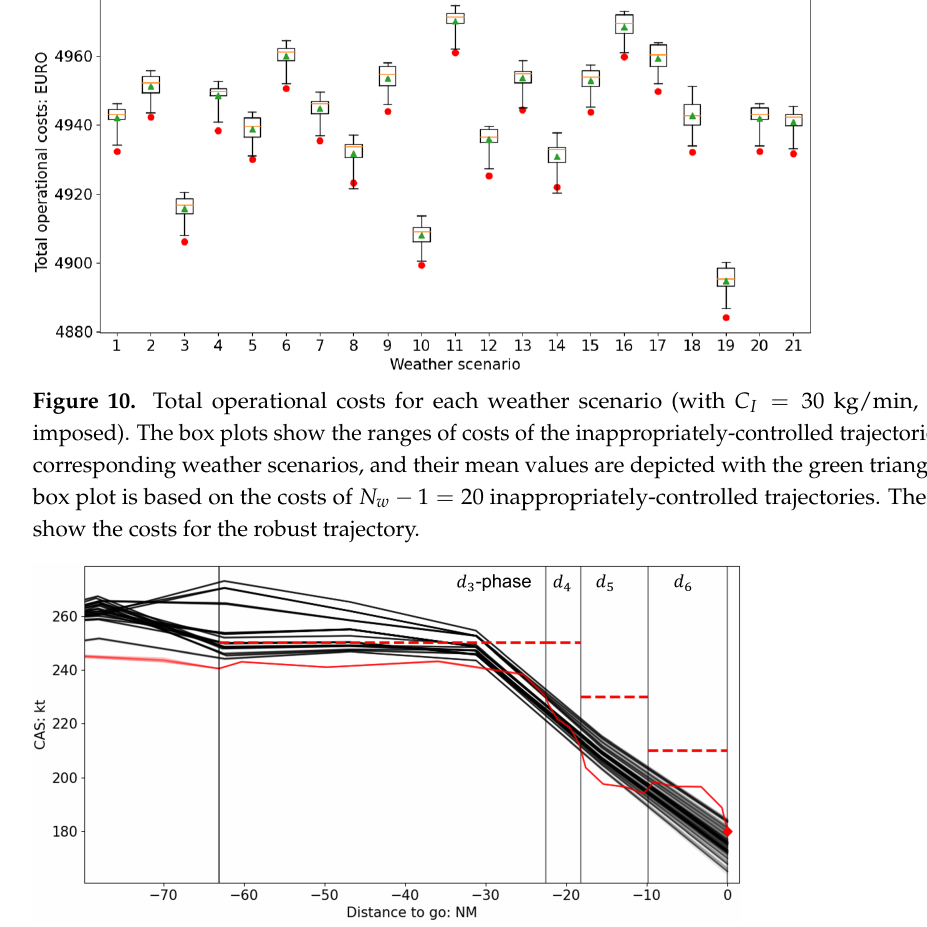
Figure 11. CAS profiles in the last 4 phases (with C I = 20 kg/min, RTA not imposed). The black profiles are inappropriately-controlled trajectories and the red are the robust trajectories. The ver- tical lines are the phase edges and the horizontal dashed red lines show the limitations for the corresponding phases. The red diamond at the end of d 6 phase depicts the final